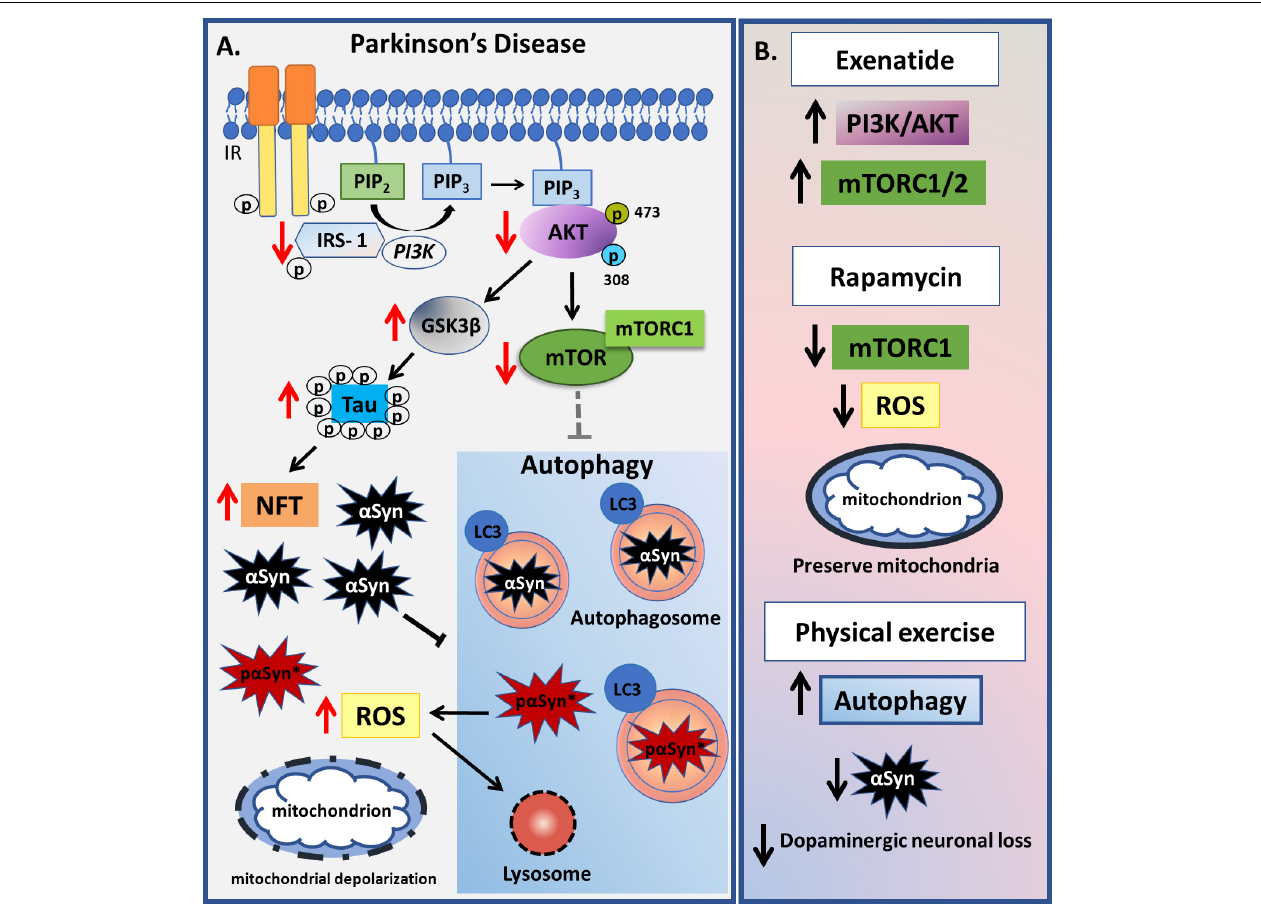
FIGURE 4 | Summary of changes related to insulin-autophagy pathway observed in Parkinson’s Disease. (A) In Parkinson’s disease, a decrease in PI3K-AKT-mTOR signaling is observed, which leads to GSK3 β activation. GSK3 β hyperphosphorylates tau protein leading to neurofibrillary tangles deposition. mTORC1 complex is inactive which causes autophagy to become activated. Otherwise, high levels of α -Synuclein ( α Syn) impair the autophagic process together with increased mitochondrial reactive oxygen species (ROS). ROS leads to abnormal permeabilization of lysosomal membranes, thereby causing lysosomal depletion and the accumulation of autophagosomes, resulting in inefficient autophagy. As a result of an incomplete α Syn autophagic degradation, a new reactive specie called p α Syn ∗ is generated inside autophagosomes and when released in cytosol it associates with mitochondrion being highly mitotoxic. Damaged mitochondrion is indicated by dashed line. (B) Some pharmacological and non-pharmacological strategies that act in PI3K-AKT-mTOR-autophagy signaling are presented. Exenatide-treated patients have a sustained increase in IRS-1 phosphorylation levels, total AKT and pAKT as well as increased levels of mTOR, reverting the impaired signaling observed in PD pathophysiology. Rapamycin, which specifically blocks mTORC1 activity, was able to decrease oxidative stress and mitochondrial injury in animal models, whereas physical exercise is associated with an increase in autophagy and a decrease in both α Syn aggregates and dopaminergic neuronal